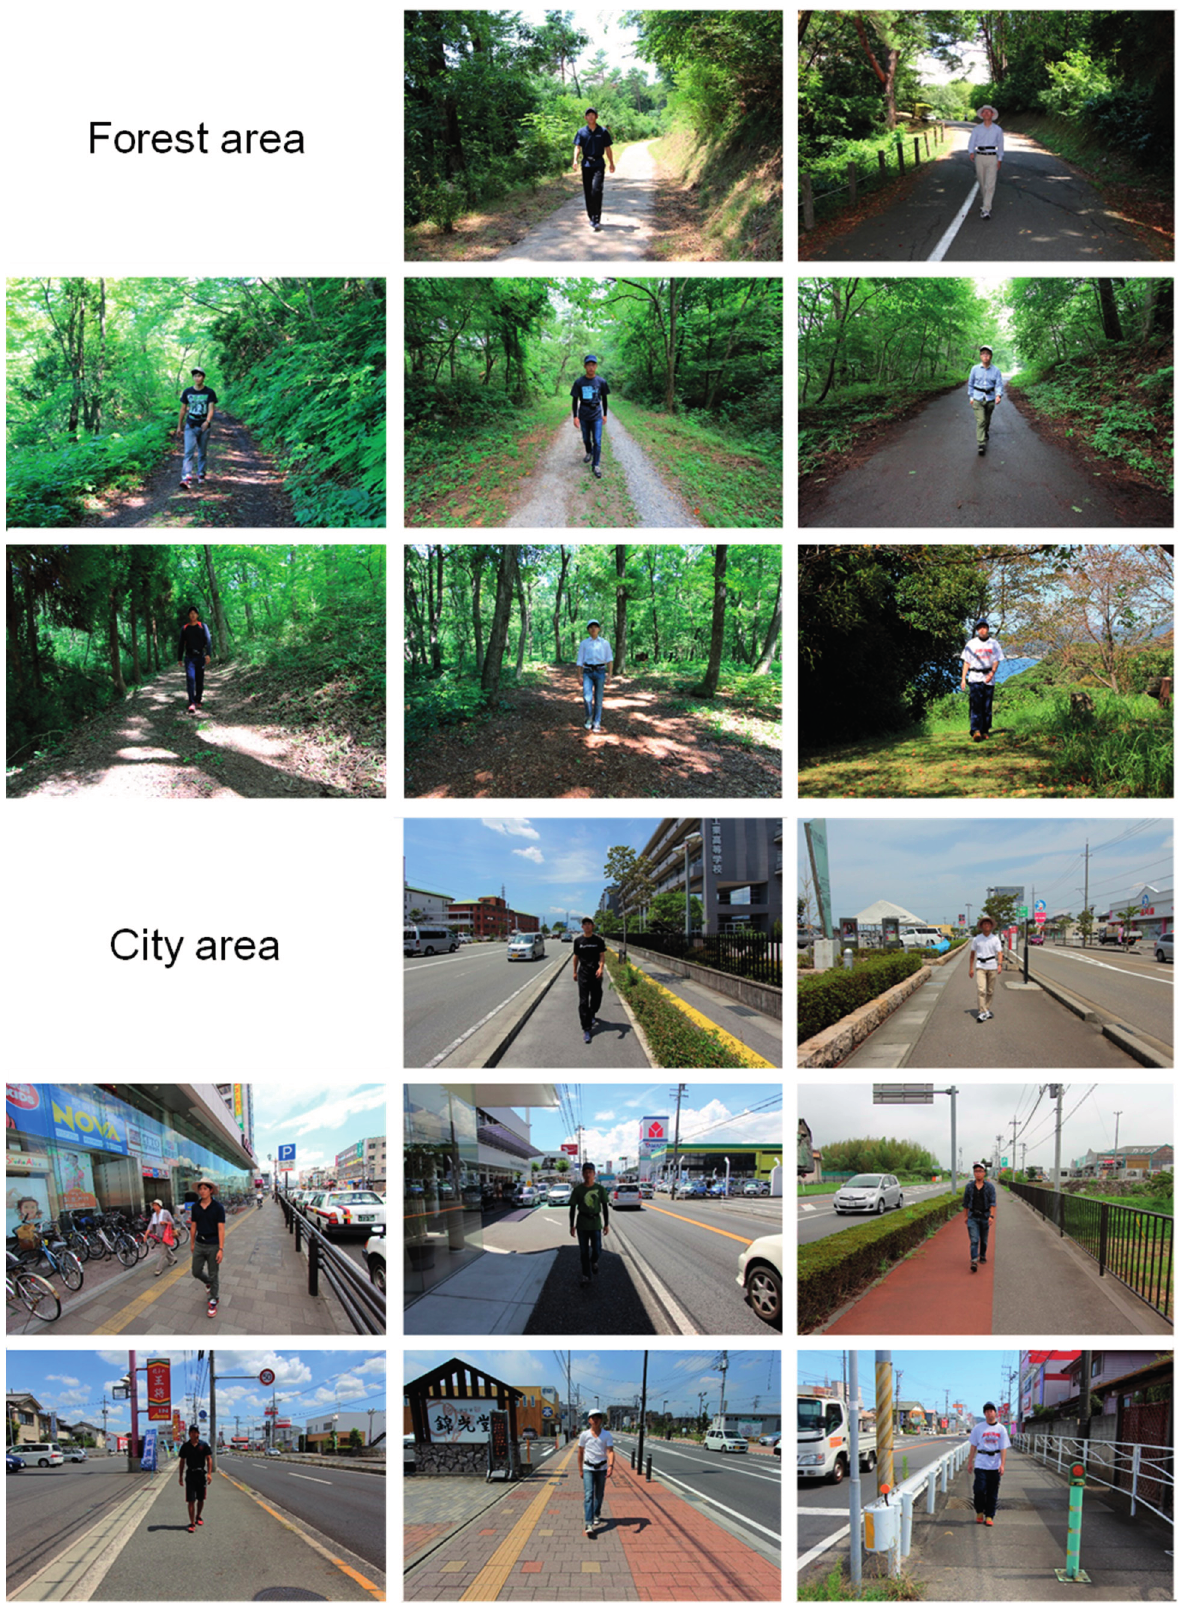
Figure 1. Experimental scene in a forested and city